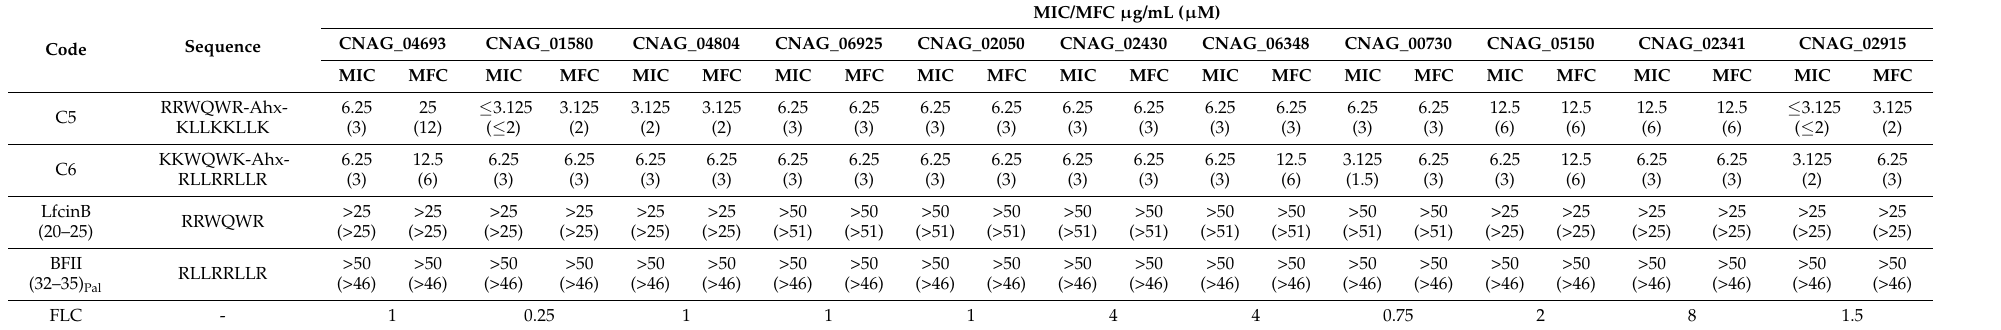
Table 2. Antifungal activity of fluconazole and peptides against mutants of C. neoformans var. grubii